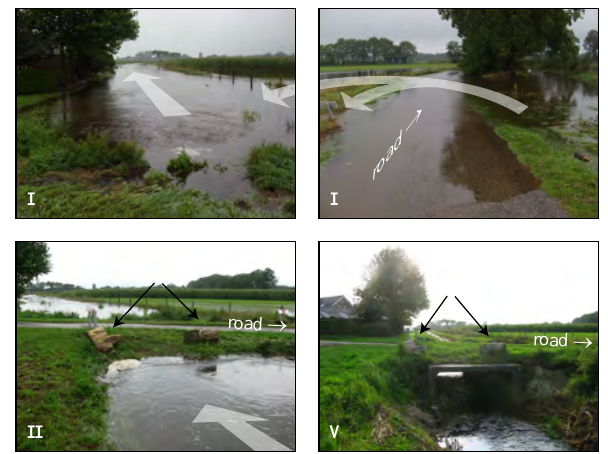
Fig. 12. The role of culverts during the 27 August 2010 flash flood. The roman numbers indicate the post-event field surveys (Table 1). Upper panels: Situation directly after the flood. Upwelling water reveals the exit of the submerged culvert. The resulting backwa- ter feedback allows water to bypass the obstacle on the right by flowing over the road and the adjacent field back into the brook (arrows). Lower left panel: upstream entry of the culvert. Logs (black arrows) deposited by flood and flow marks in grass (upper left panel) indicate that water flowed over the culvert at flood peak. Lower right panel: situation two weeks after flood with flood marks indicated. The photos in the top panels of Fig. 8 are taken from the same location as the photos in this figure, but in upstream rather than downstream